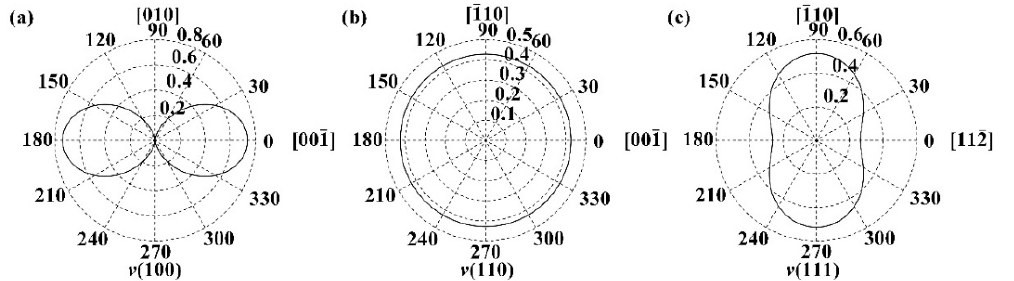
Figure 8. Direction dependence of Poisson’s ratio on low-index planes of AuCu: ( a ) (100), ( b ) (110), and ( c ) (111).